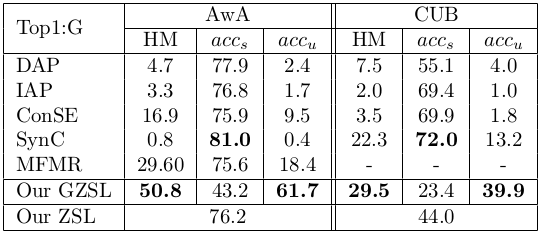
Table from the paper: A Unified approach for Conventional Zero-shot, Generalized Zero-shot and Few-shot Learning
Table text:
Top1:G
AwA
CUB
HM
acc s
acc u
HM
acc s
acc u
DAP
4.7
77.9
2.4
7.5
55.1
4.0
IAP
3.3
76.8
1.7
2.0
69.4
1.0
ConSE
16.9
75.9
9.5
3.5
69.9
1.8
SynC
0.8
81.0
0.4
22.3
72.0
13.2
MFMR
29.60
75.6
18.4
-
-
-
OurGZSL
50.8
43.2
61.7
29.5
23.4
39.9
OurZSL
76.2
44.0